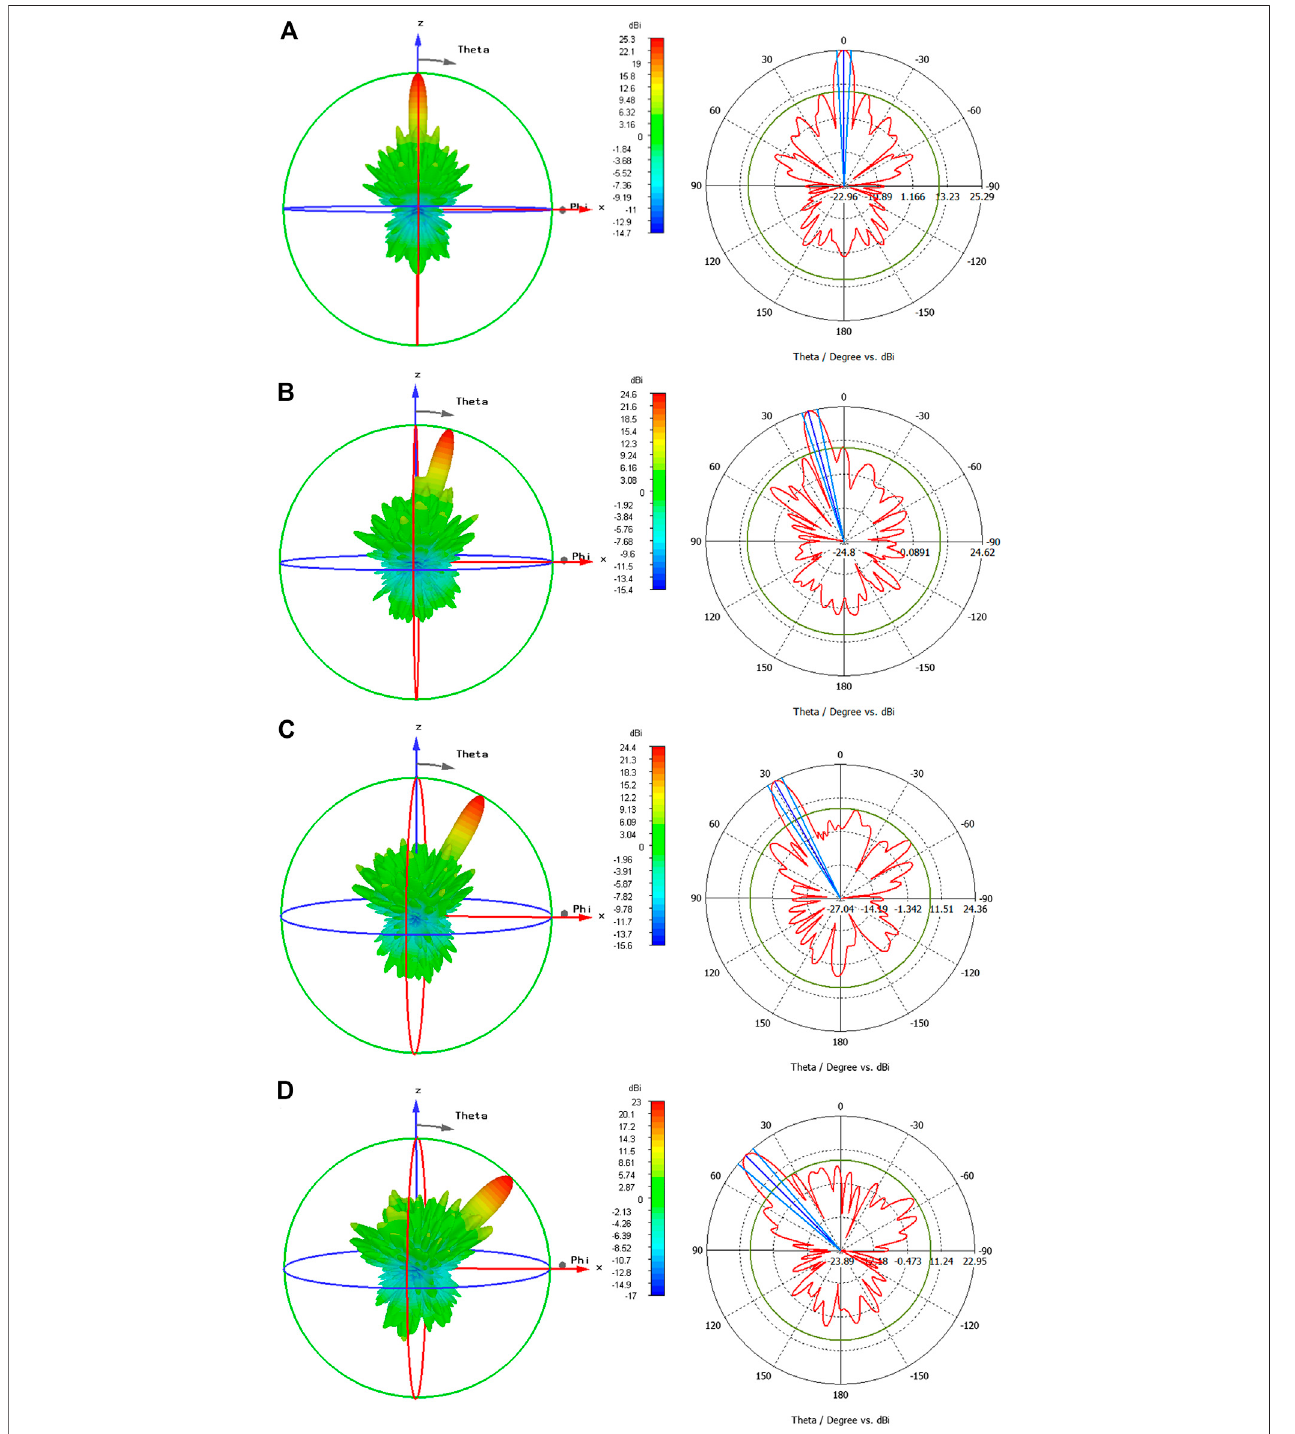
FIGURE 5 | Simulated 3-D and 2-D far- fi eld radiation patterns for four beam directions (A) θ (cid:1) 0 ° (B) θ (cid:1) 15 ° (C) θ (cid:1) 30 ° (D) θ (cid:1) 45 ° .